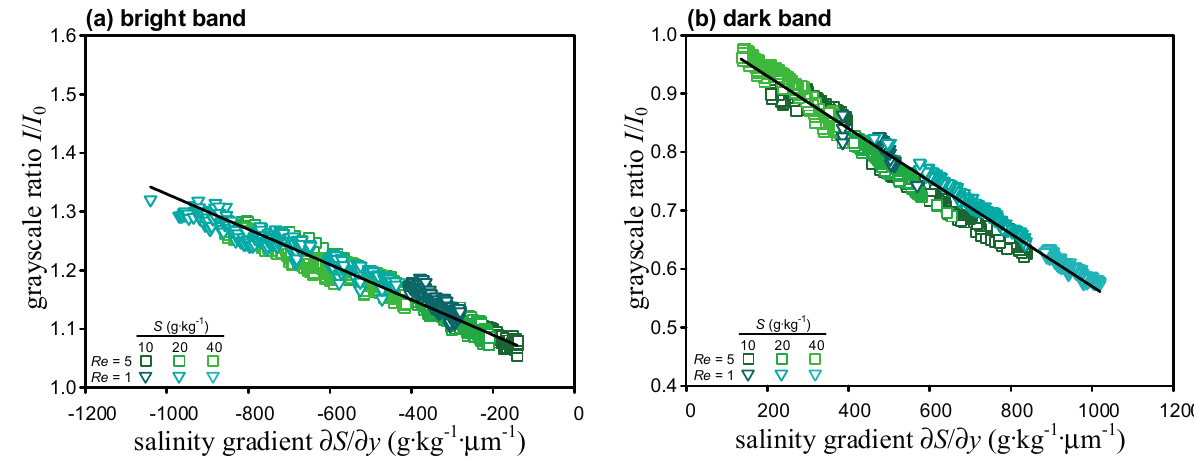
Figure 3. Variations of grayscale ratio with salinity gradient for ( a ) ∂ S / ∂ y > 0 and ( b ) ∂ S / ∂ y <